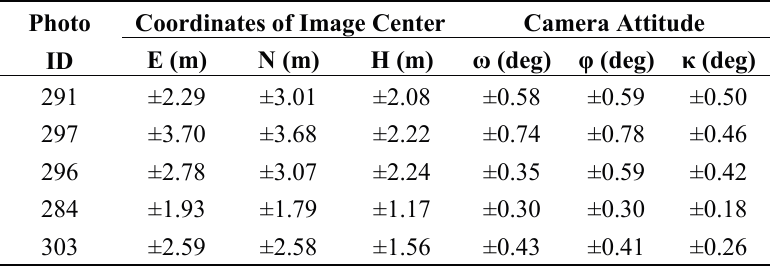
Table 2. Test 2—2006 lava flow in Valle del Bove (Mt Etna): standard deviations of the external orientation parameters for the five DOs showing the 2006 Etna lava flow.